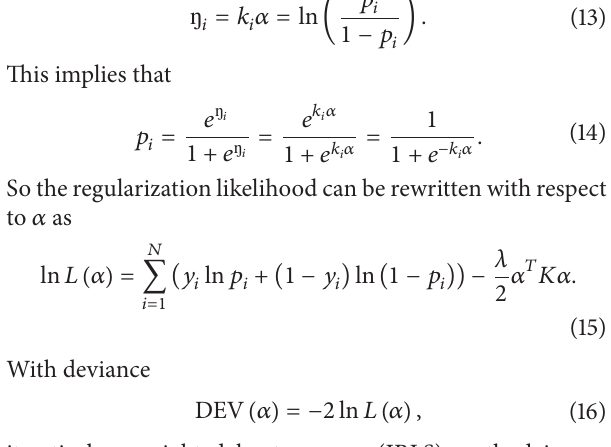
Algorithm 1 describes Iterative Weighted Kernel